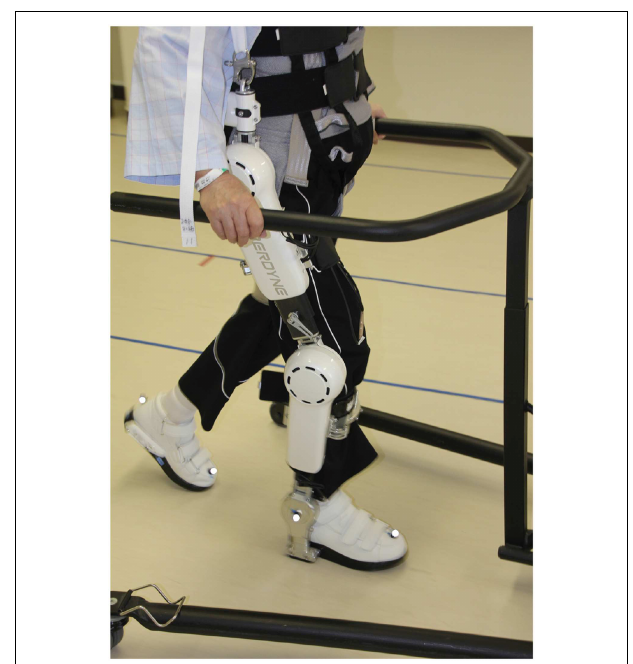
FIGURE 3 | Patient wearing HAL in a walking device (side